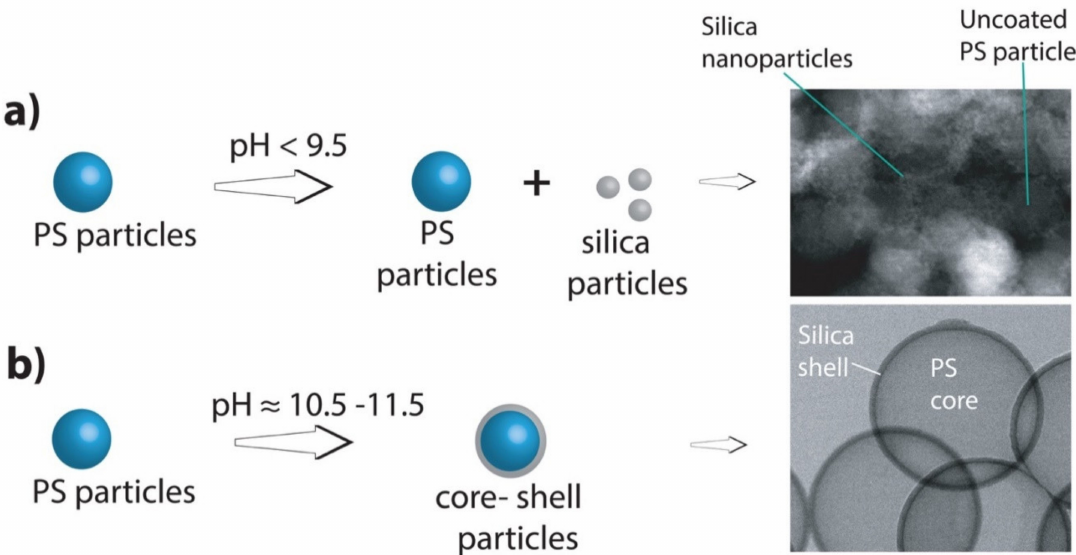
Figure 2. ( a ) (Left) schematic depiction of shell formation outcome when pH is below 9.5; (right) TEM image showing bare PS particles and free silica nanoparticles formed in the process. ( b ) Schematic depiction of shell formation outcome when pH is ≈ 11 and STEM image showing nicely formed PS core silica shell particles without any free silica particle formation. Note: Schematics show only core-shell particle formation. The step of burning the PS cores to obtain hollow silica particles is not